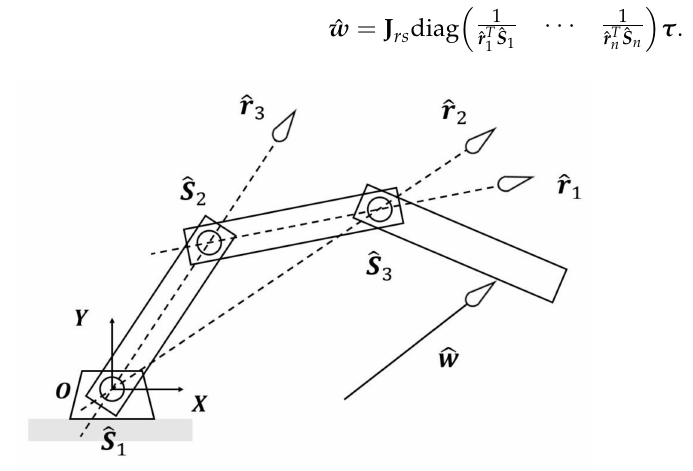
Figure 1. A planar serial